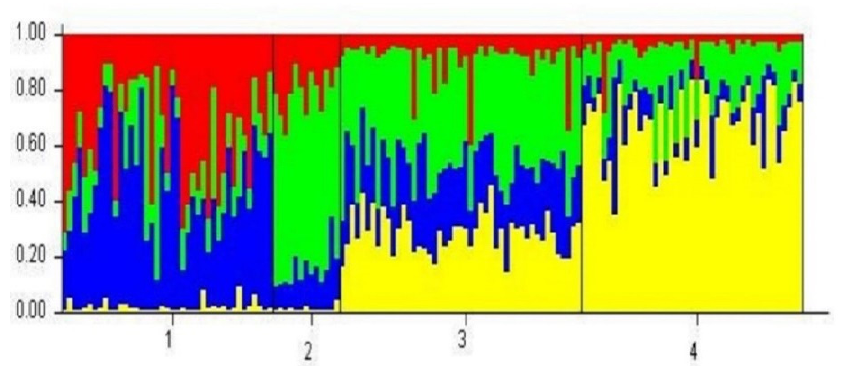
Figure 4. Genetic structure of PWN- P. thunbergii resistant trees on K4 (1) Tohoku region, (2) Kanto region, (3) Kansai region, and (4) Kyushu region. Table 4. Genetic diversity of the Kyushu PWN- P. thunbergii resistant trees using six primer markers compared with the overall genetic diversity of populations in the Kyushu area. Locus